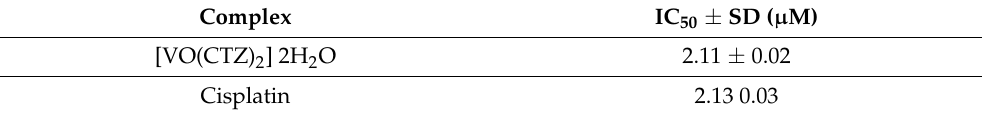
Table 12. Anticancer activity of [VO(CTZ) 2 ] 2H 2 O compared to Cisplatin and the stander division value.